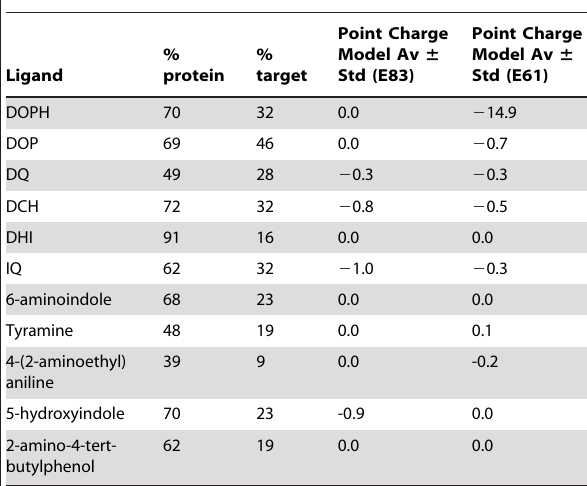
Table 1. a -syn binding of ligands in figures 1, 2 in aqueous solution observed in MD simulations . DOP and its oxidation derivatives abbreviations are explained in detail in figure 1. Column titles from left to right: (i)